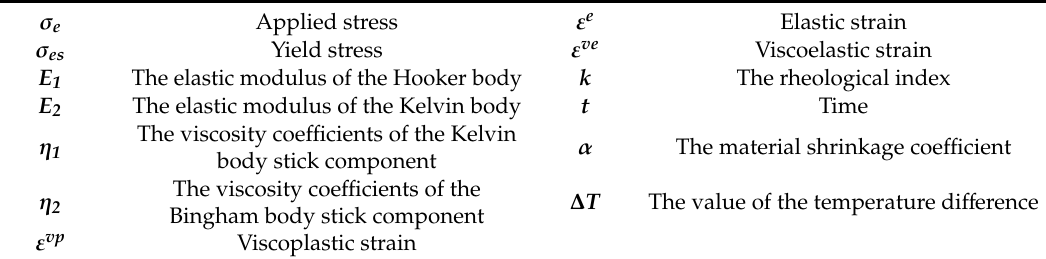
Table A1. Parameter comment